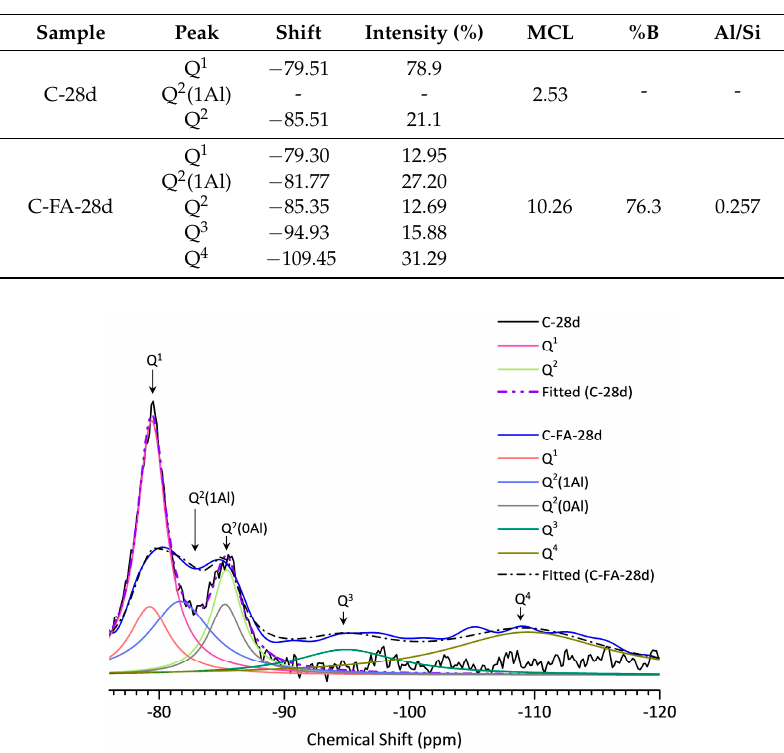
Figure 13. Deconvolution of the 29 Si MAS NMR spectrum of C-28d and C-FA-28d.